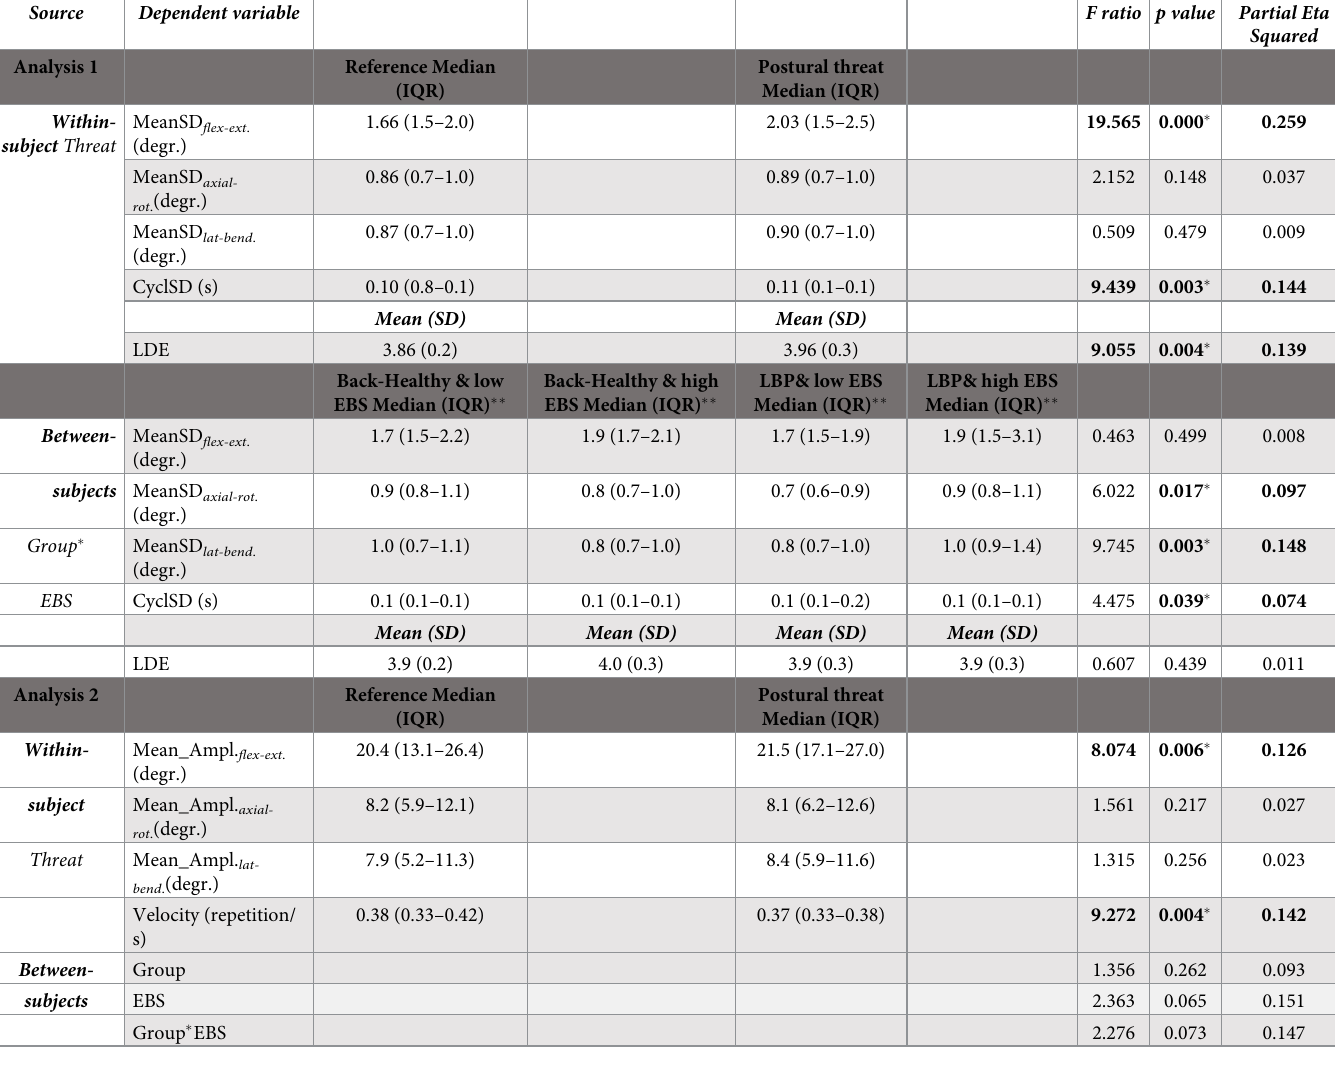
Table 2. Results of univariate ANOVAs with threat, group and high/low EBS trial_1 as independent and MeanSD , CyclSD and LDE (analysis 1), amplitude and veloc- ity (analysis 2) as dependent